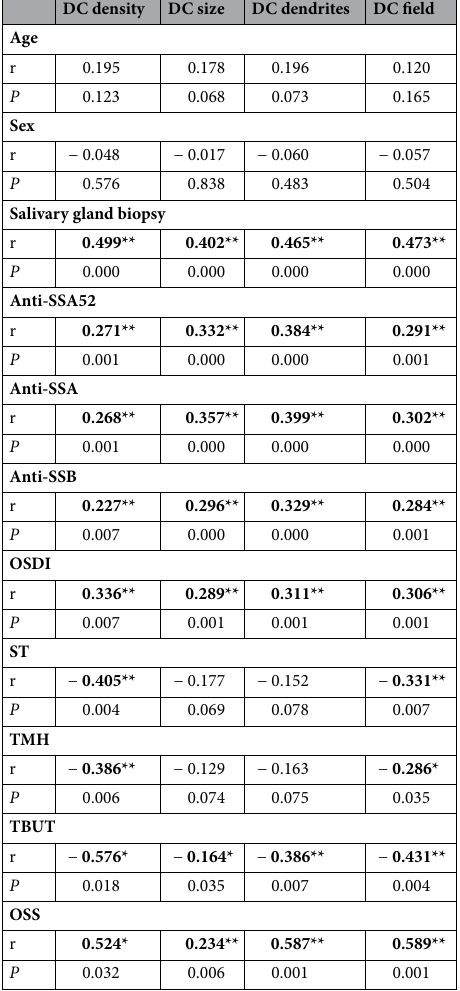
Table 3. Correlations between DCs density/morphology and clinical characteristics. DC dendritic cell, anti- SSA anti-Sjogren’s syndrome A, anti-SSB anti-Sjogren’s syndrome B, OSDI ocular surface disease index,